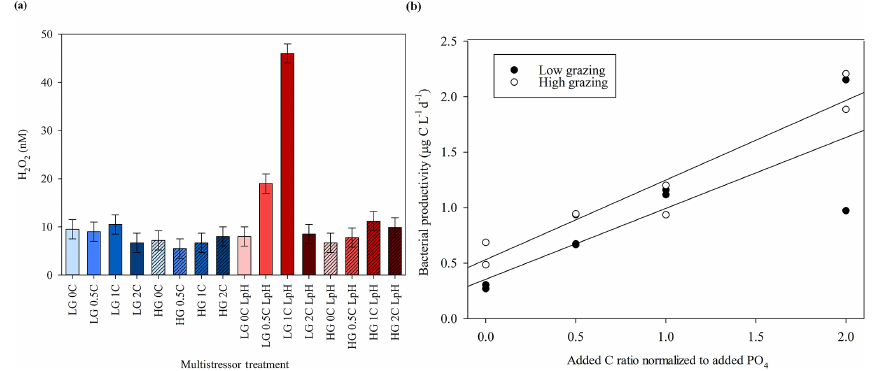
Figure 5. (a) H 2 O 2 concentrations at the end of the MultiPat experiment. Normal pH (blue); low pH (red); high grazing (hashed); DOC added at 0, 0.5, 1.0, and 2.0 times the Redfield carbon (C):phosphate ratio indicated by increasing colour density. (b) Plotting both high- and low-pH data points together (which exhibited no statistically significant difference in H 2 O 2 concentrations), bacterial productivity showed similar trends between the HG and LG